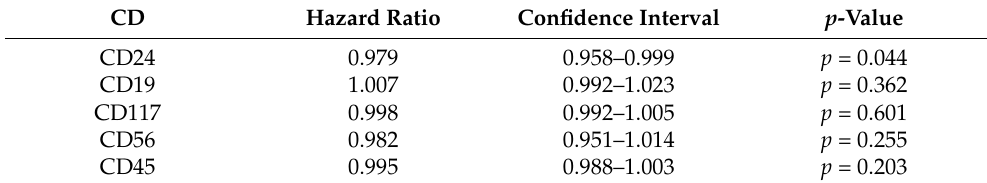
Table 5. Correlation between overall survival hazard ratio and CD expression levels as continuous variables.